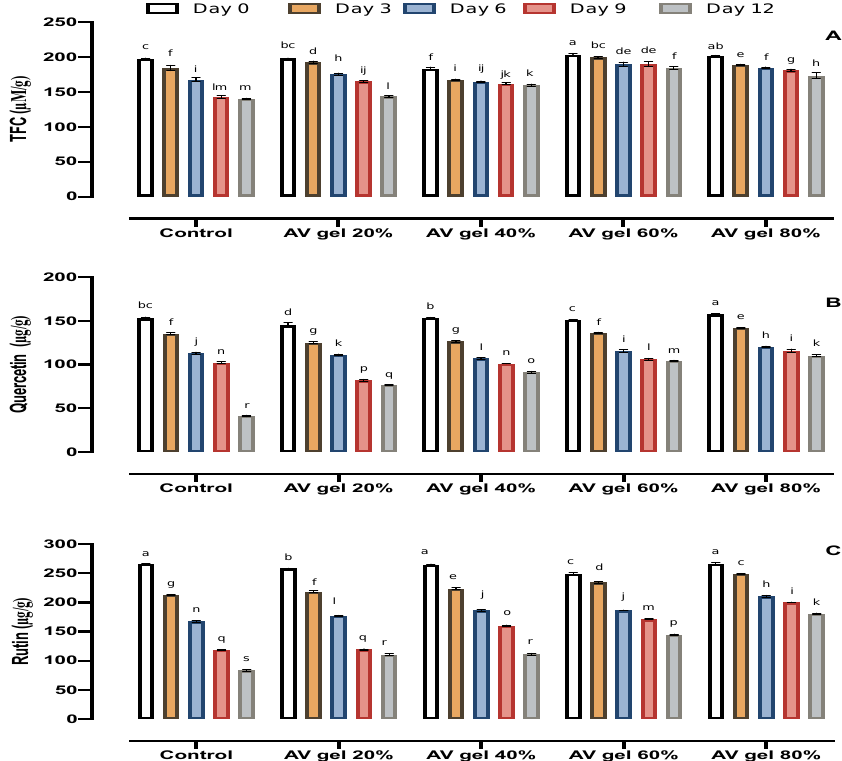
Figure 6. Effects of AV gel coating on total flavonoids content (TFC) ( A ), quercetin ( B ), and rutin ( C ) in guava fruit. Standard error shown by vertical bars; each value is the mean of three replicates. Different letters on the top of the bars indicate significant differences ( p ≤ 0.05).